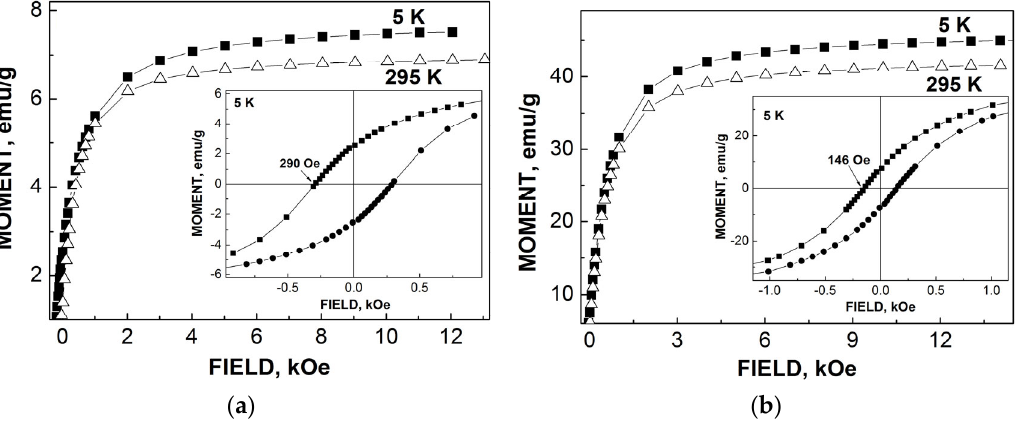
Figure 48. Isothermal magnetization curves for NA ( a ) and NB ( b ) nanoparticles at 5 and 295 K. Insets show the hysteresis loops at 5 K. Adapted from Ref. [79] with permission from Elsevier: Ma‑